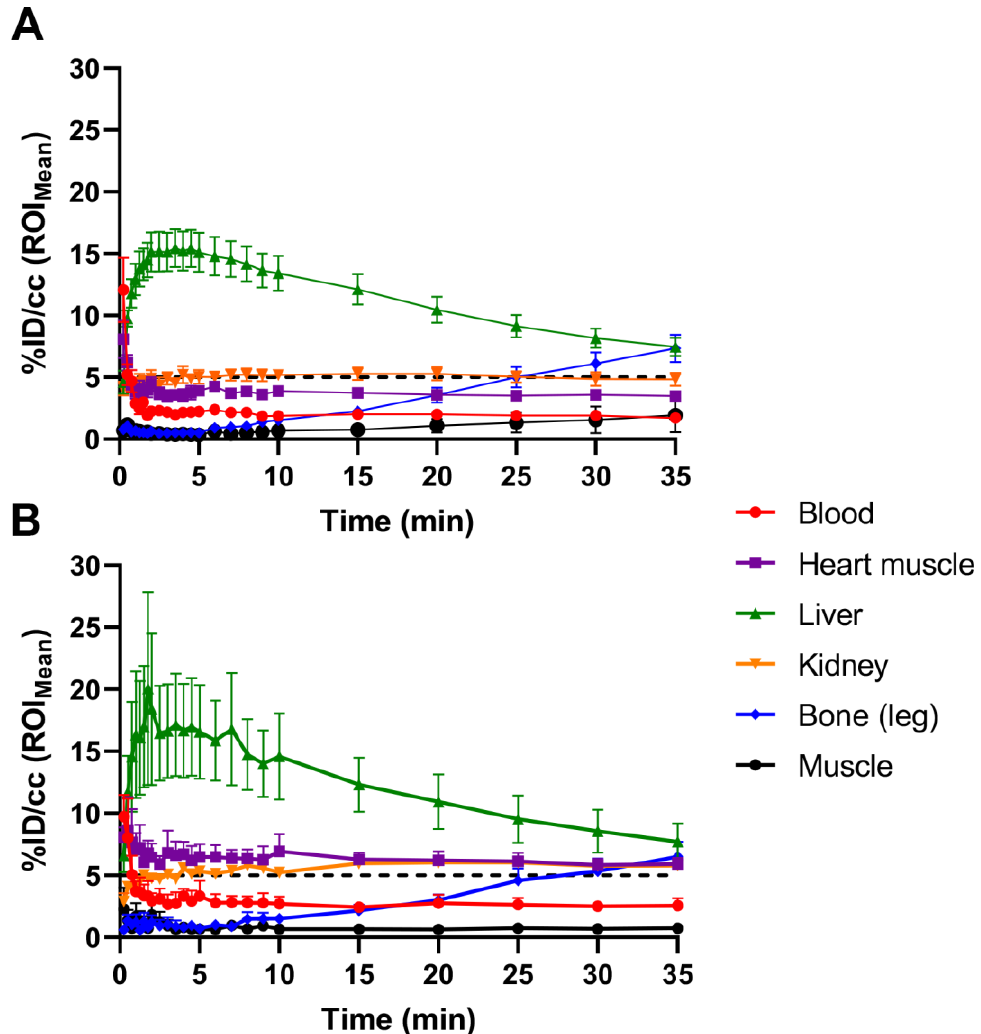
Figure 2. Comparative time – activity curves of [ 18 F]FTO uptake in WT vs. Ceacam1 −/− male mice. The % ID/cc ± SEM ( n = 4) are shown for WT ( A ) and Ceacam1 −/− mice ( B ).